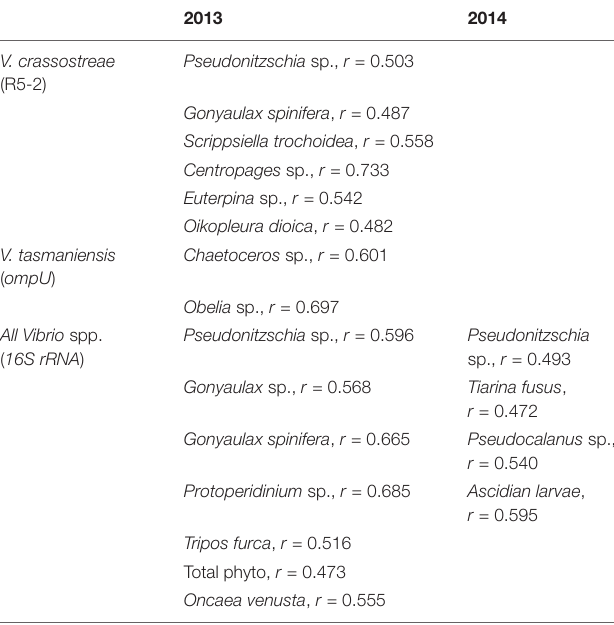
TABLE 2 | Correlations between vibrio and plankton species in the water